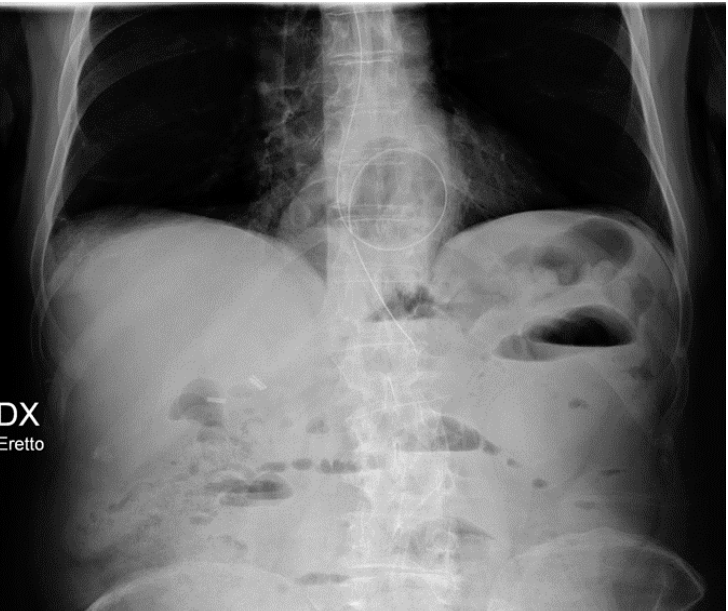
Figure 25. Abdomen X-ray showing the image of a NG tube projectively looping in the inferior mediastinum, due to a hiatal hernia; it is possible to also appreciate two metallic clips in the right hypochondrium and multiple air-fluid levels.